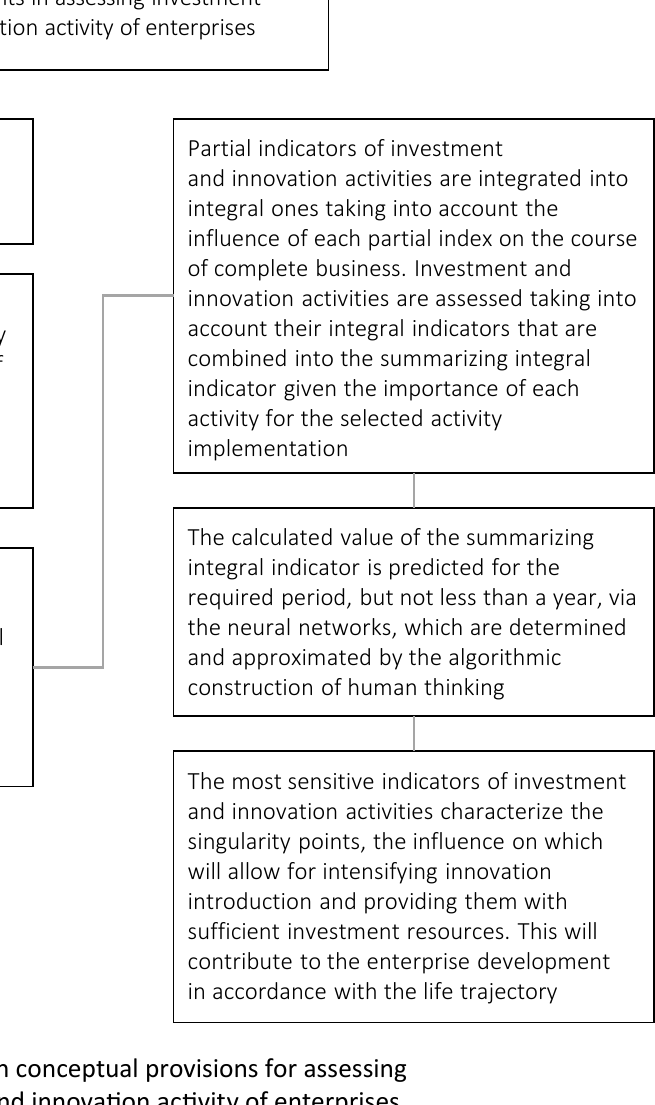
Figure 1. The main conceptual provisions for